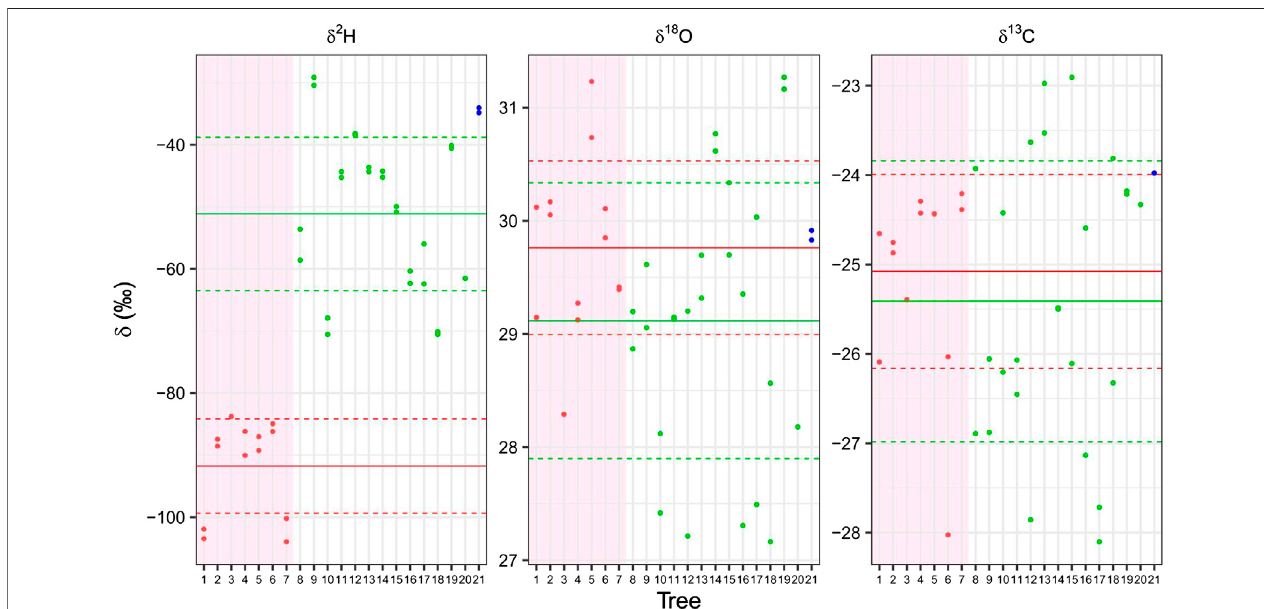
FIGURE4| Isotopesincelluloseoflivingtreesof21differentspeciescollectedattheBernBotanicalGarden.Eachboxrepresentsthecelluloseisotopes, δ 2 H δ 18 O and δ 13 C. The deciduous conifers (larch and Pseudolarix amabilis ) are displayed in red in the reddish back ground (trees 1 – 7), in green the evergreen conifers (Genus: Pinus , Cipressus , Cedrus , Taxus , Tsuga ) (trees 8 – 20) and in blue the only broadleaf gymnosperm ( Ginkgo biloba , tree 21). The means of the deciduous and of the evergreen conifer species are indicated as horizontal red and blue lines, respectively, the dashed lines shows the interval of the standard deviation. A clear distinctionbetweentheevergreenanddeciduousconifersispresentonlyfor δ 2 Hvalues,eveniftheycomefrombranchesandfromdifferentyears.1 (cid:2) Larixdecidua ;2 (cid:2) Larix decidua polonica ; 3 (cid:2) Larix gmelinii ; 4 (cid:2) Larix kaempferii ; 5 (cid:2) Larix laricina ; 6 (cid:2) Larix sibirica ; 7 (cid:2) Pseudolarix amabilis ; 8 (cid:2) Cedrus atlantica ; 9 (cid:2) Cephalotaxus harringtonia ;10 (cid:2) Cupressusnootkatensis ;11 (cid:2) Pinusbungeana ;12 (cid:2) Pinuscembra ;13 (cid:2) Pinusmugo ;14 (cid:2) Pinusnigra ;15 (cid:2) Pinusnigra 16 (cid:2) Pinuspeuce ;17 (cid:2)